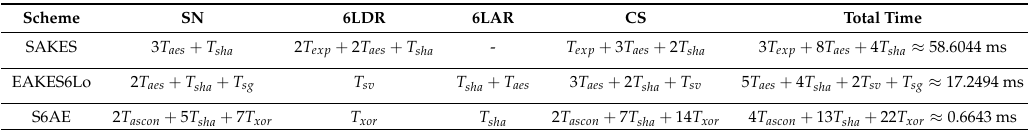
Table 6. Computational overheads.